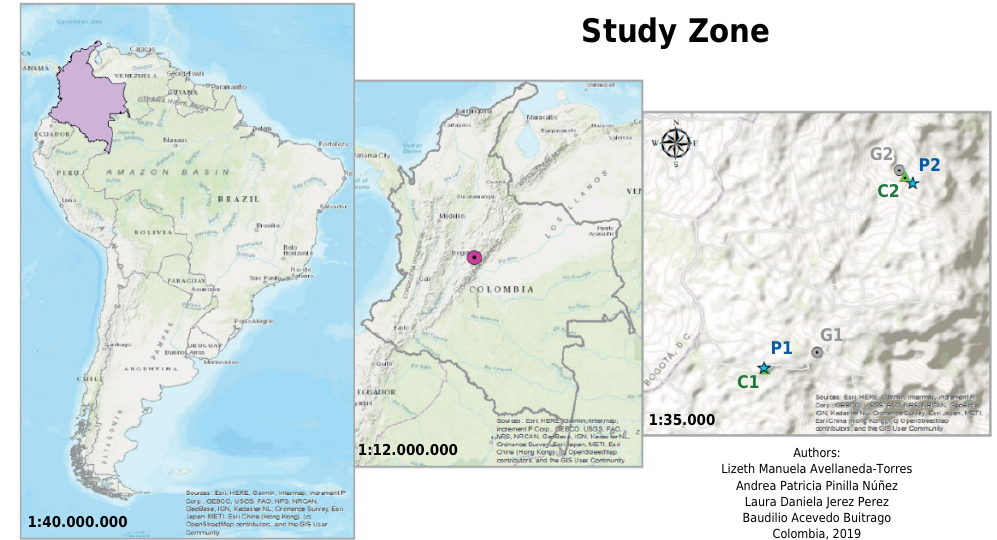
Figure 1. Map presenting where the study area is